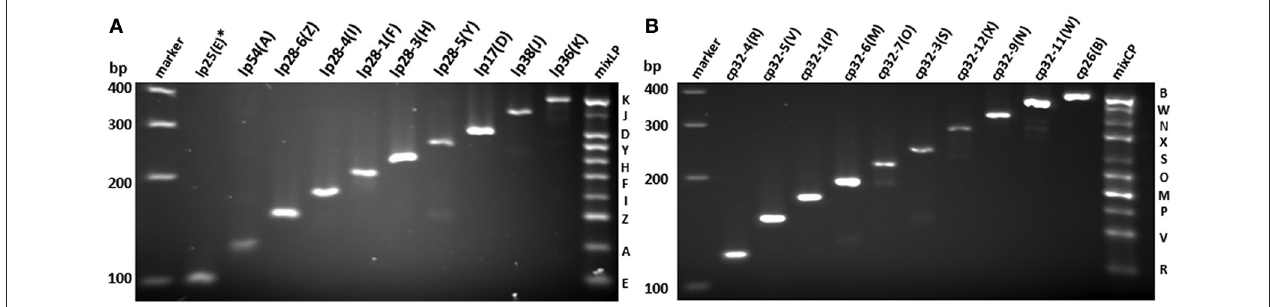
FIGURE 1 | Verification of PCR primer specificity and efficiency for each endogenous plasmid in B. burgdorferi strain 297. PCR products were separated on 3% metaphor agarose gel. Each product for linear (A) and circular (B) plasmids with corresponding designation were labeled on top. The mixed product from pooled primer mix for linear plasmids (mixLP) and circular plasmids (mixCP) were on the right of each gel, and the band corresponding to each plasmid is labeled with designated letter on the right. DNA ladder is labeled on the left. *The primer sequences for lp25(E) were based on bptA sequence.